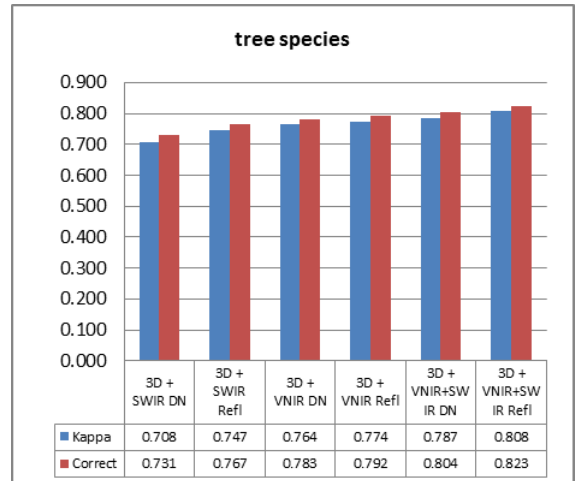
Figure 2. Results of tree species classification (kappa + proportion of correct